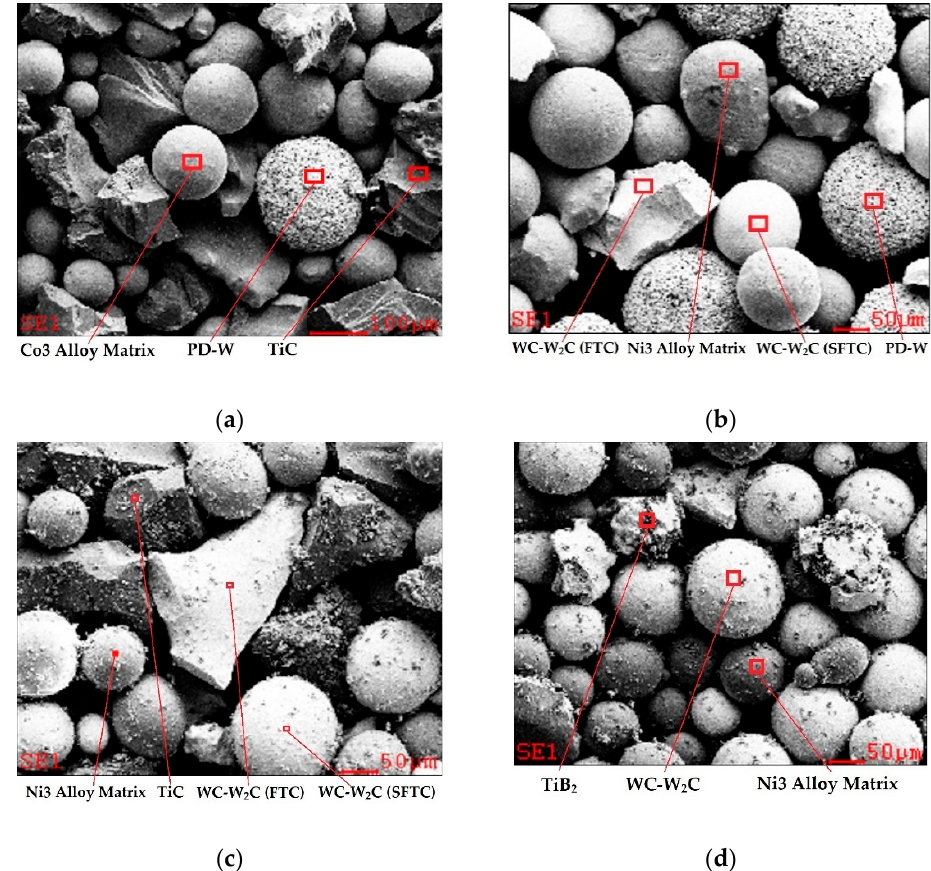
Figure 2. SEM image of the micromorphology of the powder components used for PPTAW cladding: ( a ) C1 filler material; ( b ) C2 filler material; ( c ) C3 filler material; ( d ) C4 filler material (Table 3).